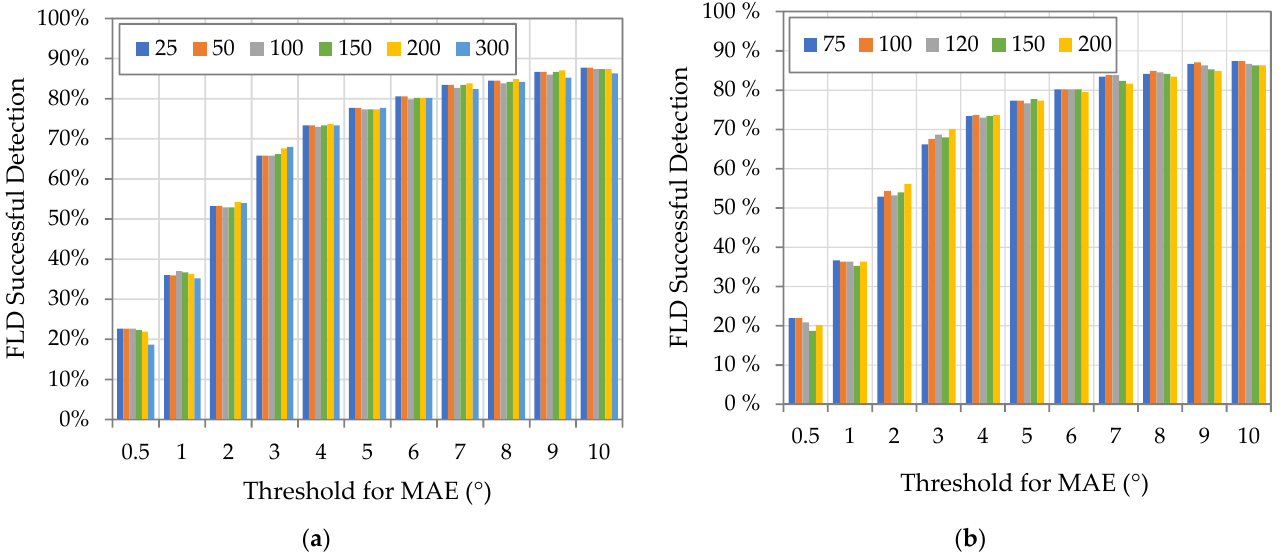
Figure 19. Results of successful detection of main cultivation direction by FLD with adjusted parameters considering different threshold values of MAE for ( a ) different cth1 values with ratio of 1:2; ( b ) cth1 = 300 with all ratios.